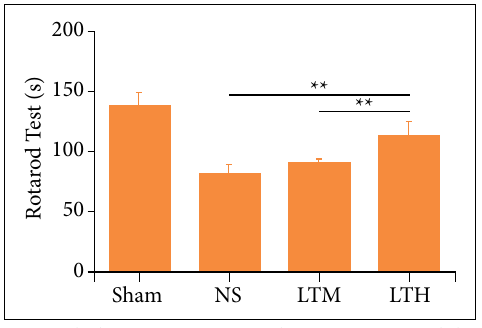
Figure 1 - Lutongkeli improved motor function of traumatic brain injury rats. The results of rotarod test were presented at 14 days after the operation. Data were presented as the mean ± standard deviation, (a) The images of neurons after Nissl staining, scale bar=50μm. (b) The percentage of neuron suvival after LTH treatment.